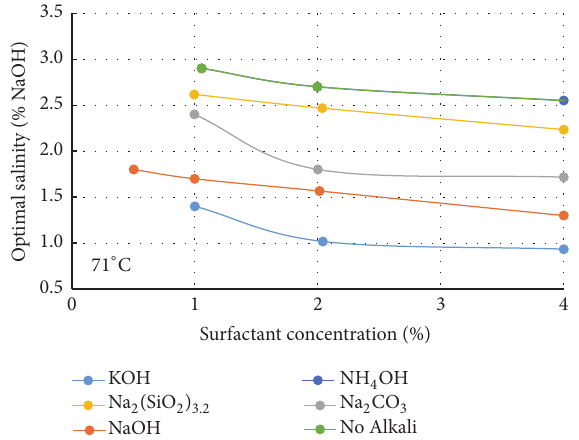
Figure4:Influenceofcombinedcationcontentonoptimalfor1% wt alkali chemical, brine, n-tetra decane, and surfactant